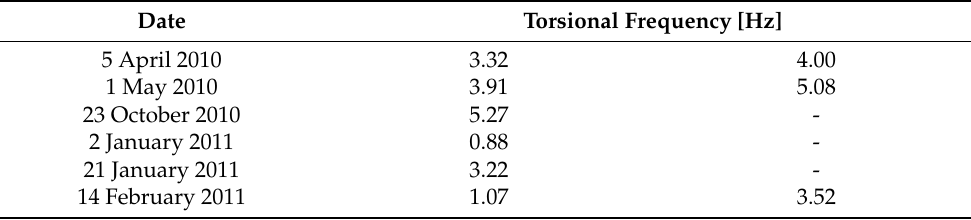
Table 3. Identified torsional frequencies of the building for the selected